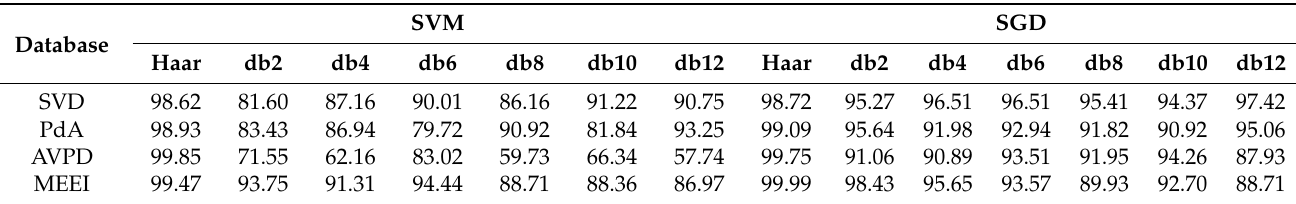
Table 19. Voice dysfunction categorization accuracy (%) using Haar and